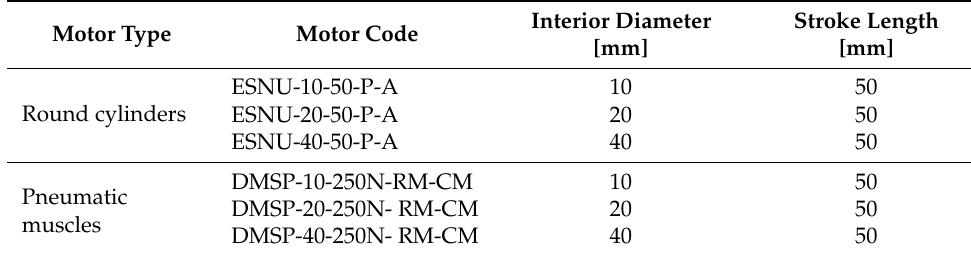
Table 1. Characteristics of the studied pneumatic